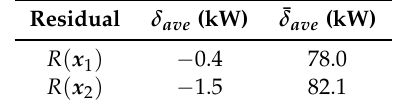
Table 3. Statistical behavior of the residuals between measurement and estimation, for the different random choices of the D0 and D1 data set. Turbine T9